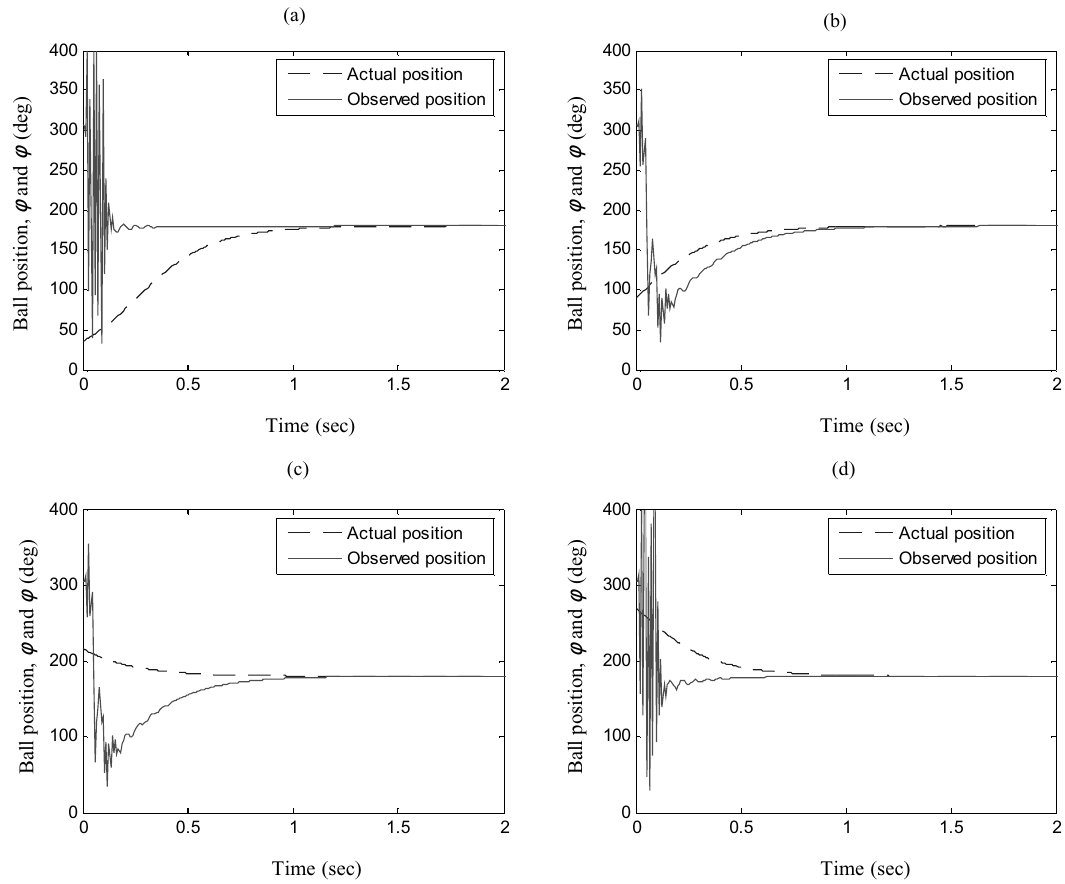
Fig. 10. Observed ball position based on the designed sliding-mode ball observer with l x = 460, k x = 4, a 1 = 10, a 2 = 1 and initial ball position at (a) 36 ◦ , (b) 90 ◦ , (c) 216 ◦ and (d) 270 ◦ . for measuring translational motions, and a stroboscope accompanied with a CCD camera to capture ball positions. For a steel race used for the present study, the rolling friction is identified as 1 . 5 × 10 − 6 N-m [9]. In addition,